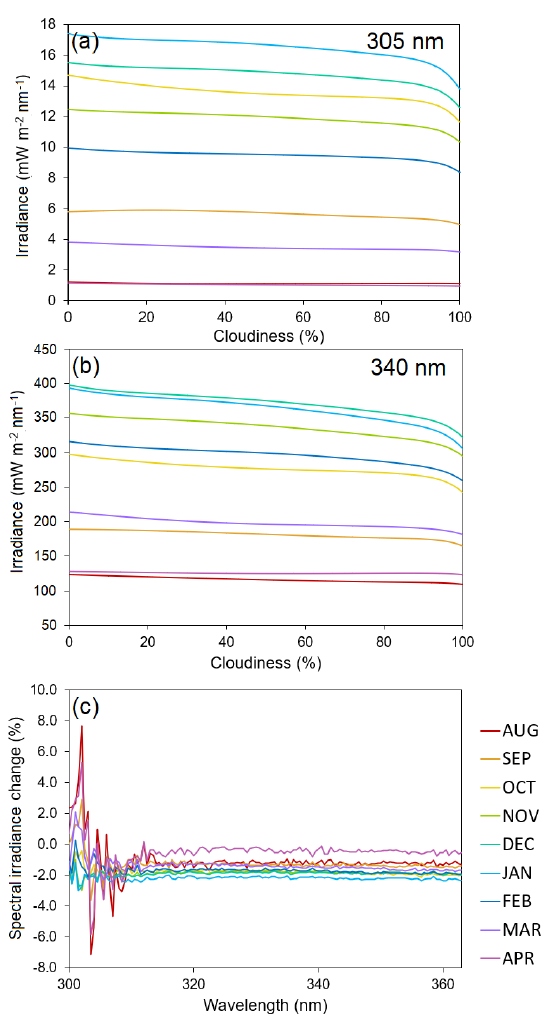
Figure 9. Modeled relationships between UV irradiance and cloud cover for different months. Panels (a) and (b) show the modeled UV irradiance at 305nm (a) and 340nm (b) as a function of cloud cover. Panel (c) shows the relative change in spectral UV irradiance resulting from an increase in cloud cover by 10%, calculated with reference to the monthly median spectra.